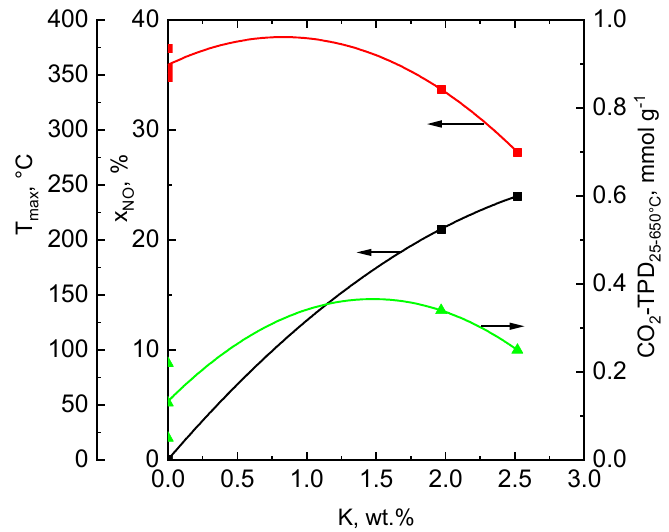
Figure 8. Dependence of NO conversion to N 2 (black curve), temperatures of first reduction peak in the TPR measurements (red curve), and basicity (CO 2 desorbed in the range of 25 to 650 °C, green curve) on the amount of potassium in the catalysts.